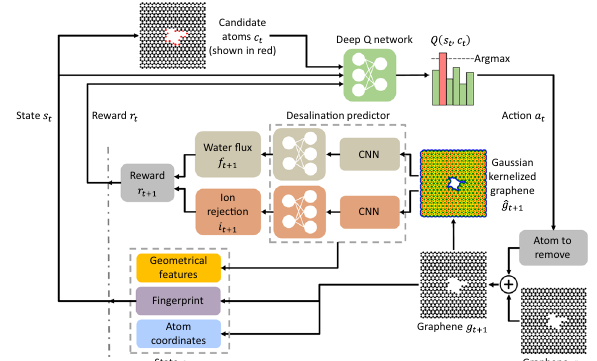
Fig. 1 Overview of AI creating nanopores for ef fi cient water desalination via the integration of CNN and DRL. The whole framework runs by removing atoms sequentially. At each timestep t , at most one candidate atom (colored as red) is removed from the current graphene nanopore g t to generate a updated nanopore g t + 1 . Any dangling atoms caused by the removal of candidate atom are also removed from g t . g t + 1 is fed into a CNN-based performance predictor to predict water fl ux f t + 1 and ion rejection rate i t + 1 . Meanwhile, the geometrical feature is extracted from the CNN. The reward is then calculated from the predicted i t + 1 and f t + 1 . The geometrical feature is concatenated with the fi ngerprint and atom coordinates as the state s t + 1 . Given g t + 1 , candidate atoms to remove are picked from those located at the edge of the nanopore. The DRL agent constructed upon deep Q- network takes the reward, candidate atoms, and state as input to determine the next atom to remove from the